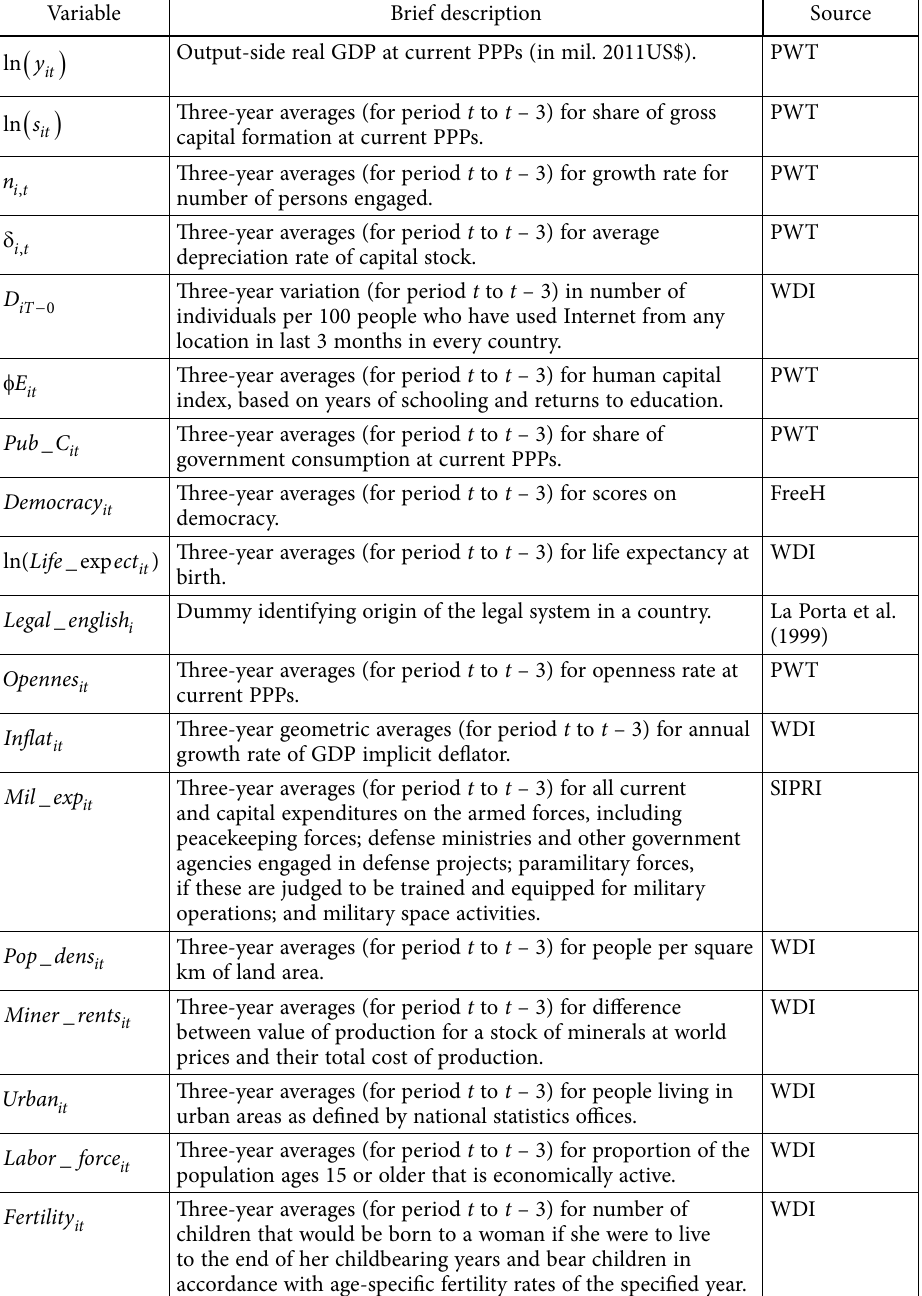
PWT PWT PWT WDI PWT